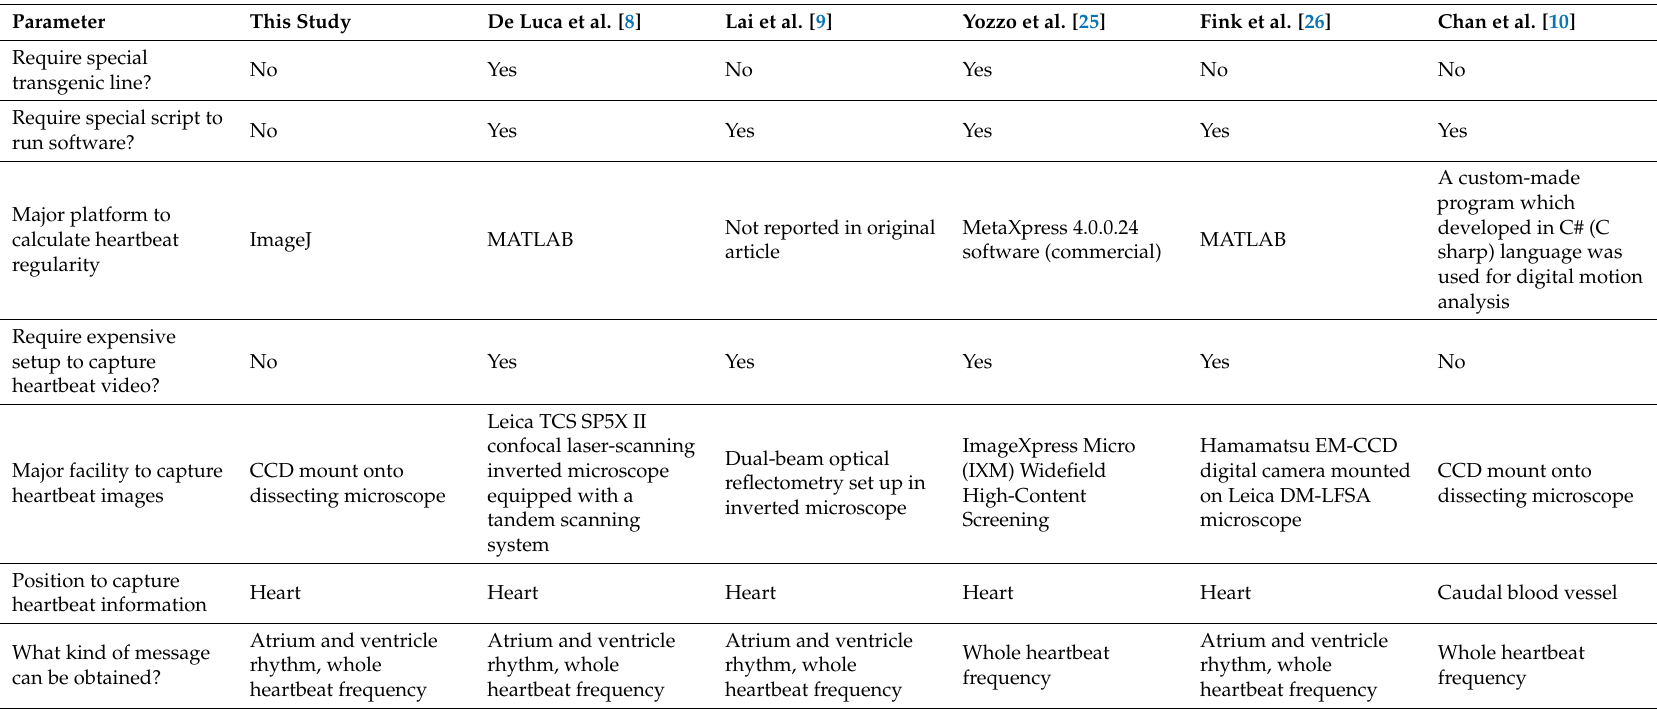
Table 1. Comparison of different methods to measure heartbeat regularity in